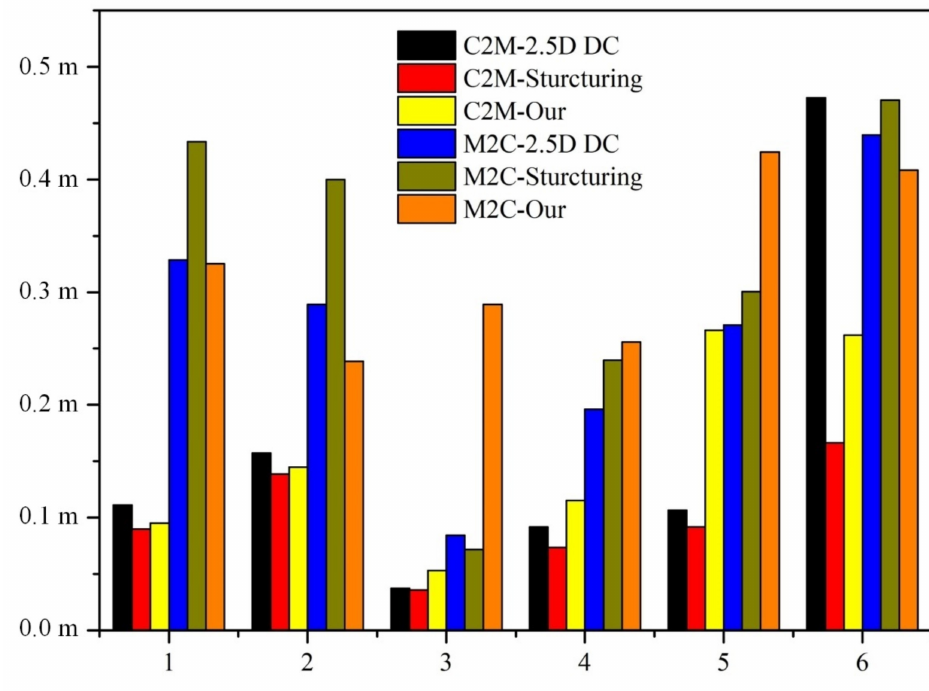
Figure 15. Mean C2M and M2C distances from Buildings #1 to #6 generated by 3D models from 2.5D DC method [55], structuring method [56], and the proposed